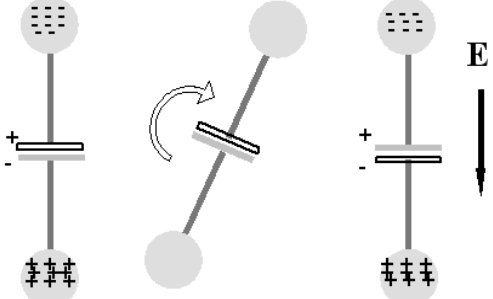
Figure 11. Device (rotating electrostatic device ( r.e.d. ) or ball recorder ) composed of a conductor, with a condenser at its middle, that is rotated inside an ambient electric field E . The alternating voltage difference between the condenser plates monitors E .